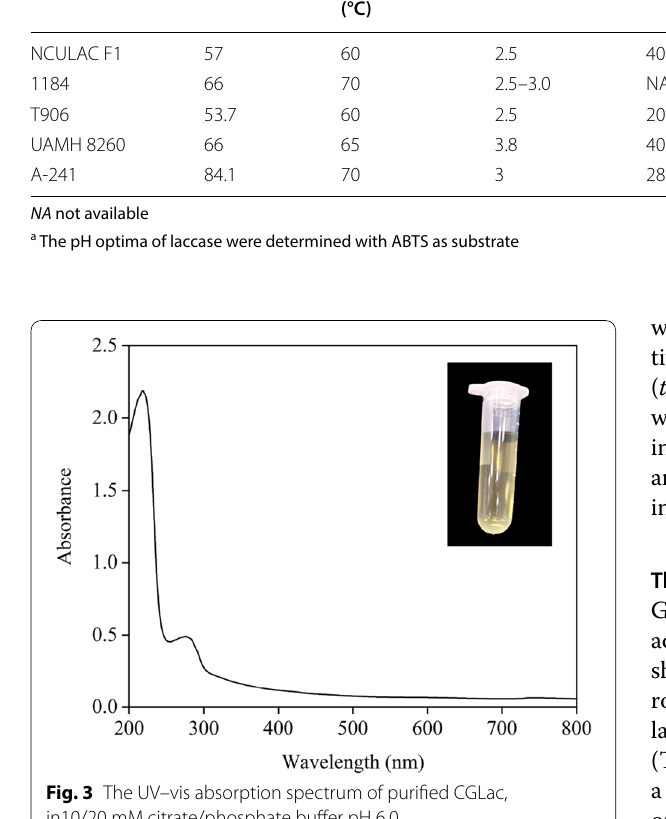
Table 2 Characteristics of laccases from different C. gallica strains